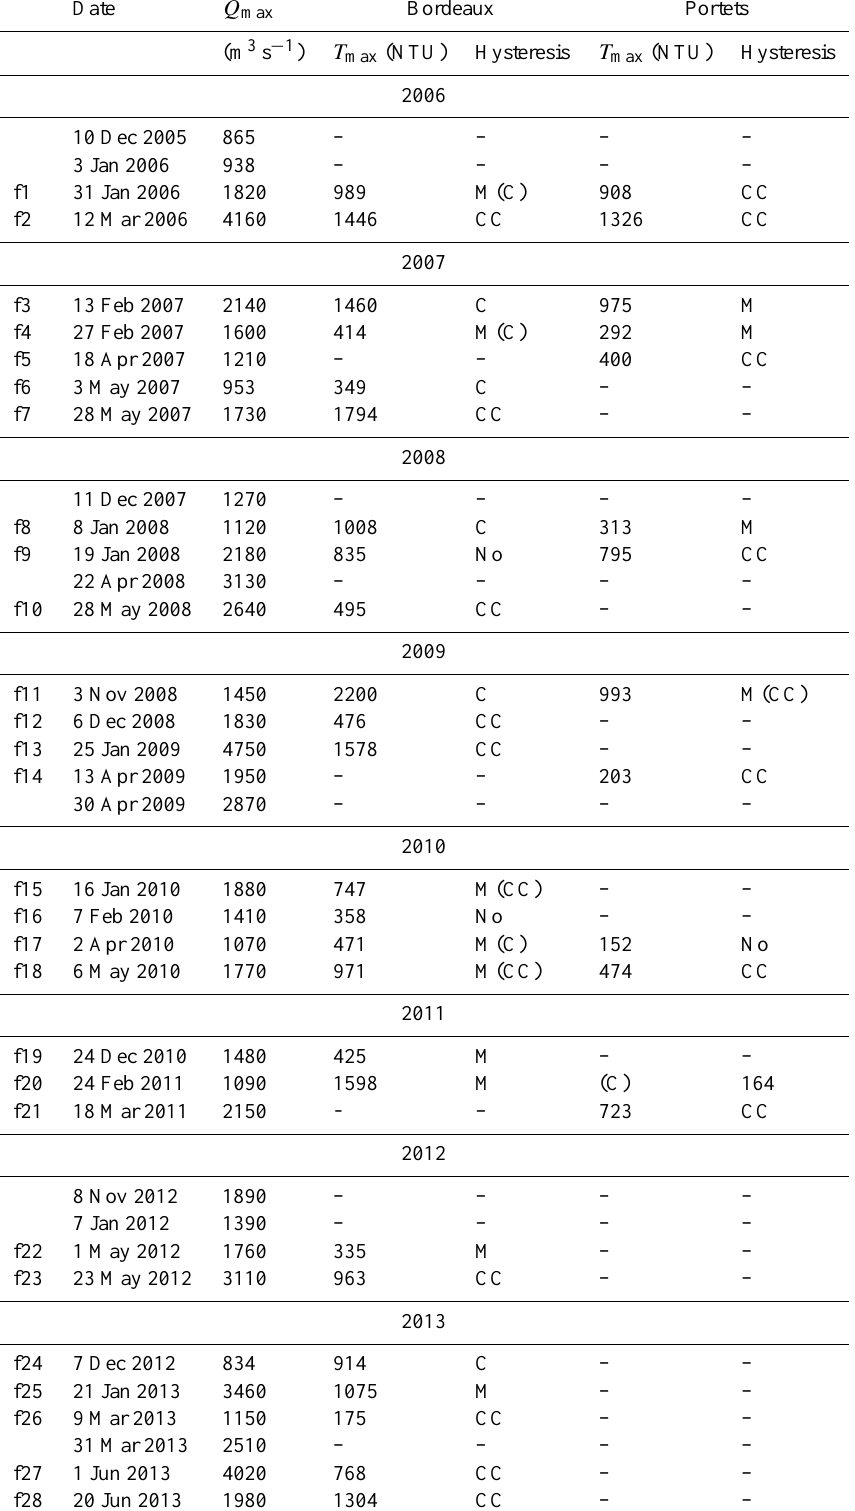
Table 1. Discharge and turbidity characteristics of flood events for the period 2005 to mid-2014 in the tidal Garonne River (Bordeaux and Portets stations). Flood event are numbered by f plus a number according to Fig. 3. Hysteresis loops are classified as: [C] clockwise; [CC] counterclockwise; [M] mixed; [No] no trend. Mixed loops with a clear clockwise [M(C)] or counterclockwise [M(CC)] predominance are specified. Flood without turbidity record are included to facilitate the interpretation of the hysteresis